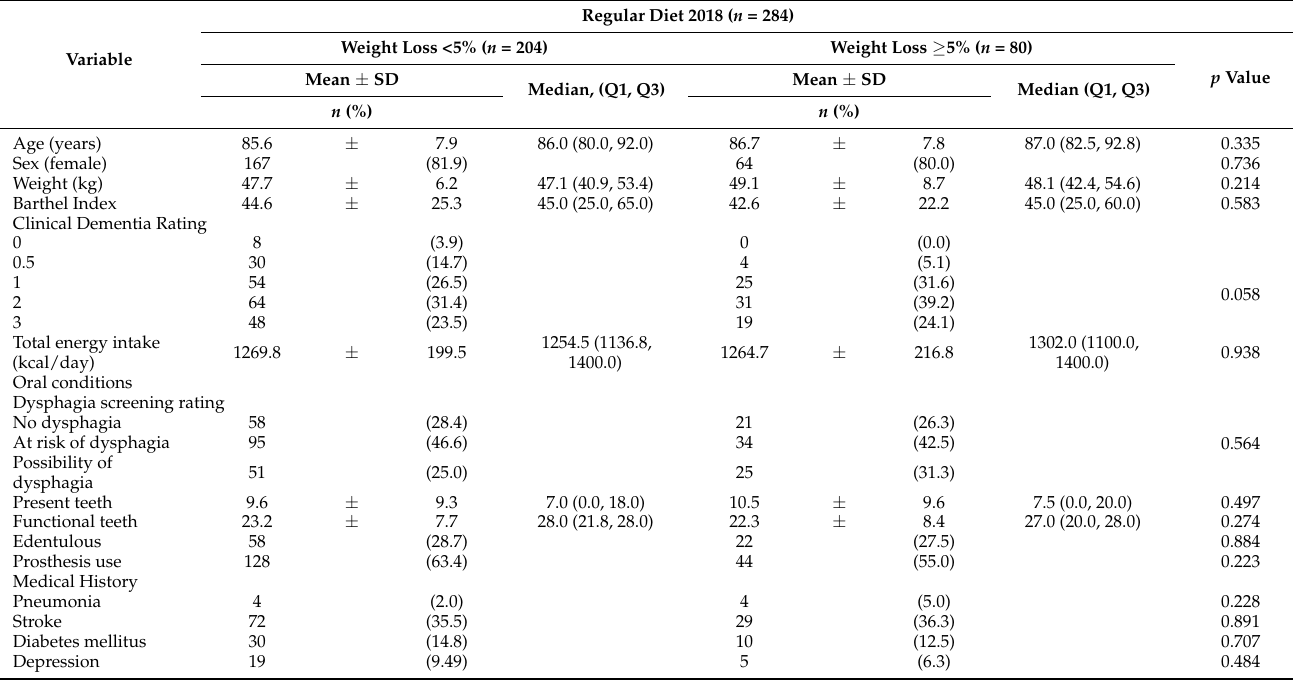
Table 2. Baseline comparisons between the weight loss group and maintenance group in the regular diet group.